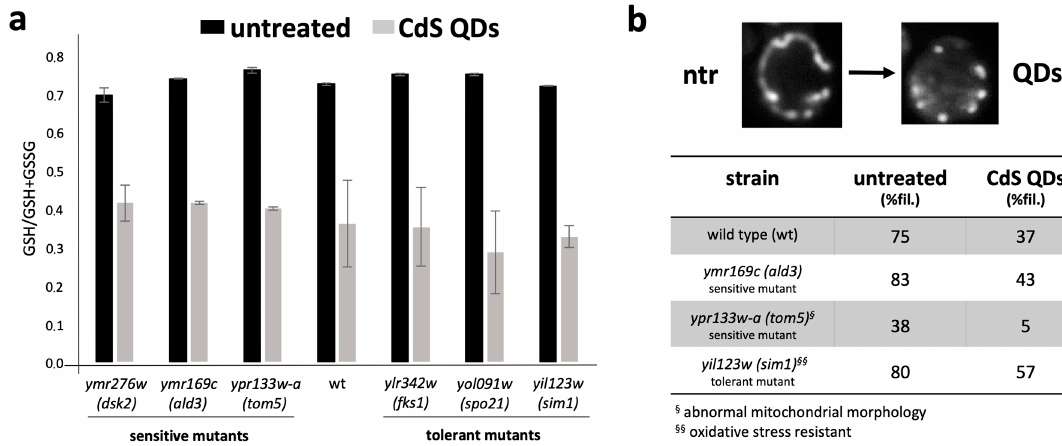
Figure 5. ( a ) Histogram reporting the GSH/GSH+GSSG ratio in wild type yeast cells and in tolerant or sensitive mutants. Untreated (black, ntr), treated (grey, QDs) with 50 mg · L − 1 of CdS QDs. ( b ) Top: pictures depicting the percent of filamentous mitochondria in untreated and treated (50 mg · L − 1 ) cells, respectively. The cells were transformed with a plasmid expressing mitochondrial RFP [20]. Bottom: table indicating the percentage of filamentous mitochondria in untreated (ntr) and treated (QDs) yeast samples.